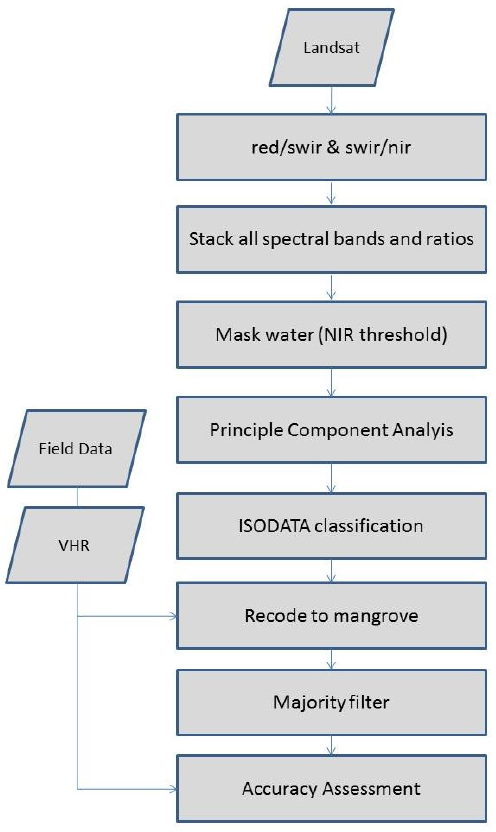
Figure 2. Mapping method for mangrove detection using Landsat, very high resolution (VHR) data and field